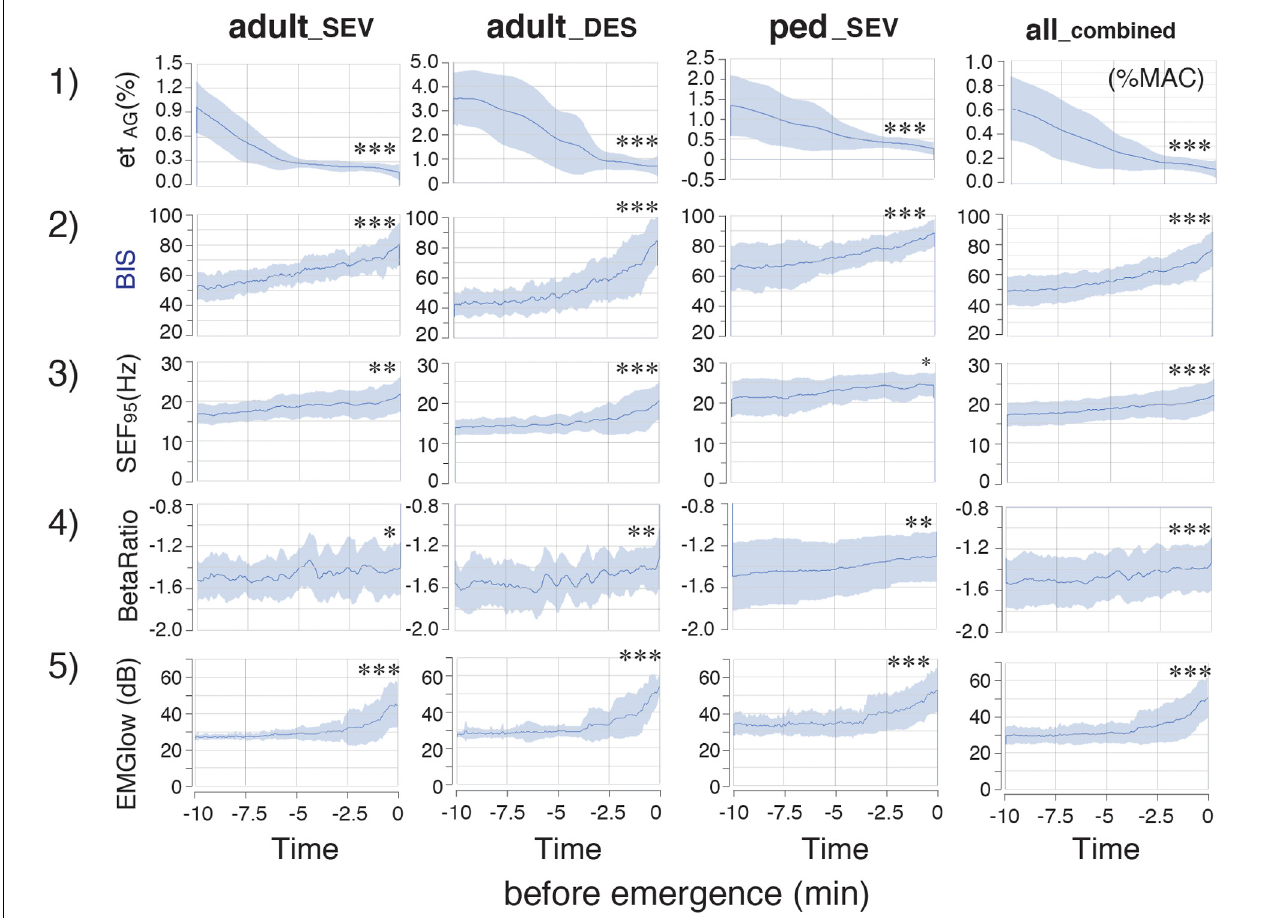
FIGURE 3 | Time-course changes of parameters in the adult _ SEV , adult _ DES , ped _ SEV , and all _ combined groups. et AG , BIS, SEF 95 RelativeBetaRatio (BetaRatio), and EMGlow of EEG. Plots of the time course from the hypnotic condition to the awake state of (1) et AG , (2) BIS, (3) SEF 95 , and the BIS subparameters (4) RelativeBetaRatio (BetaRatio), and (5) EMGlow. adult _ SEV , adults anesthetized with sevoflurane ( n = 20); adult _ DES , adults anesthetized with desflurane ( n = 20); ped _ SEV , pediatric patients anesthetized with sevoflurane ( n = 20); all _ combined , all patients from the three groups ( n = 60). Data are shown as mean ± SD. ∗ p < 0.05, ∗∗ p < 0.01, and ∗∗∗ p < 0.001 by Student’s paired t -test between the values at EM - 10 and EM 0 . BIS, bispectral index; EM - 10 , 10 min before emergence; EM 0 , at the time of emergence; et AG , end-tidal anesthetic gas concentration; SEF 95 , spectral edge frequency below which 95% of the power of a given signal is located; EMGlow, a BIS monitor-derived electromyography parameter corresponding to absolute power in the 70–110 Hz range, and values in decibel (dB) with respect to 0.0001 µ V 2